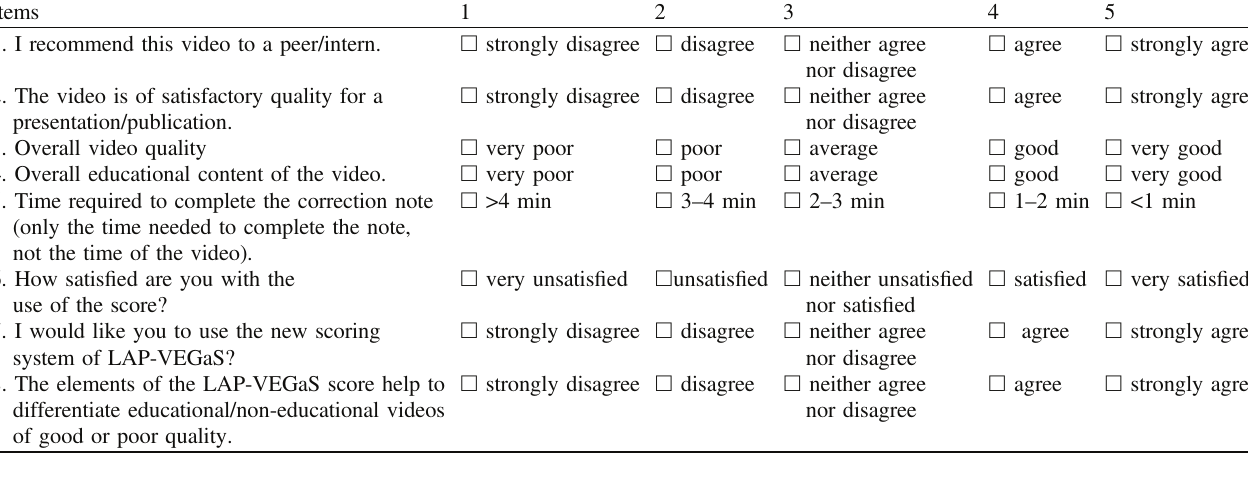
Table 2. Five-point Likert scale on single-peer/trainer video recommendations and the acceptance of the video for publication or presentation on the podium.